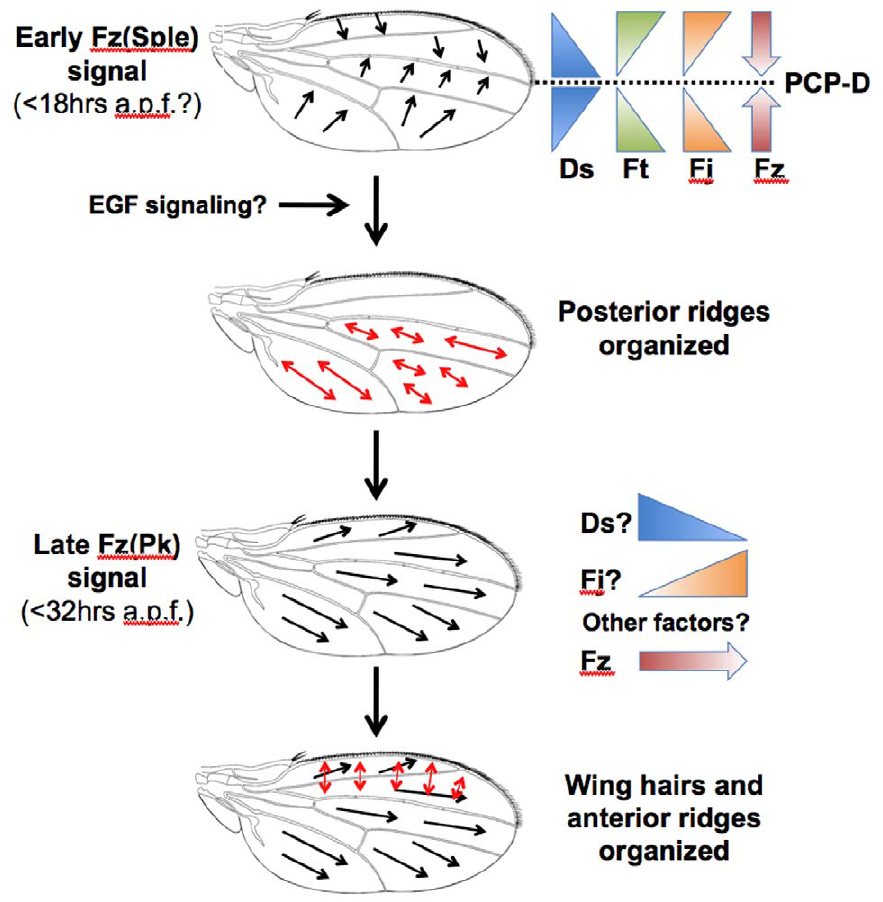
Figure 9. A model for PCP specification in the Drosophila wing. At 18 hours a.p.f., there are symmetric gradients of Ds expression that peak at the site of the L3 vein. The resulting Ds activity gradients are opposed by gradients of Ft and Fj activity. The Ft/Ds pathway organizes the direction of the Early Fz PCP signal, which points up the Ds activity gradient towards the site of the L3 vein. This Early Fz PCP signal employs the Sple isoform of the Prickle protein and determines the orientation of posterior wing ridges, which are specified orthogonal to the direction of Fz signaling. The outcome of the Early Fz PCP signal can be modified by the differentiation of wing veins, possibly due to EGF signaling. A second Fz signal occurs prior to wing hair initiation at 32 hours a.p.f. and employs the Pk isoform of the Prickle protein. The Late Fz PCP signal points distally and determines the orientation of hairs and also anterior ridges, which are specified orthogonal to the Fz activity gradient. The Late Fz PCP signal points down the contemporaneous Ds expression gradient and up a Fj expression gradient. However, it is likely that other factors are involved in controlling the direction of the Late Fz PCP signal.